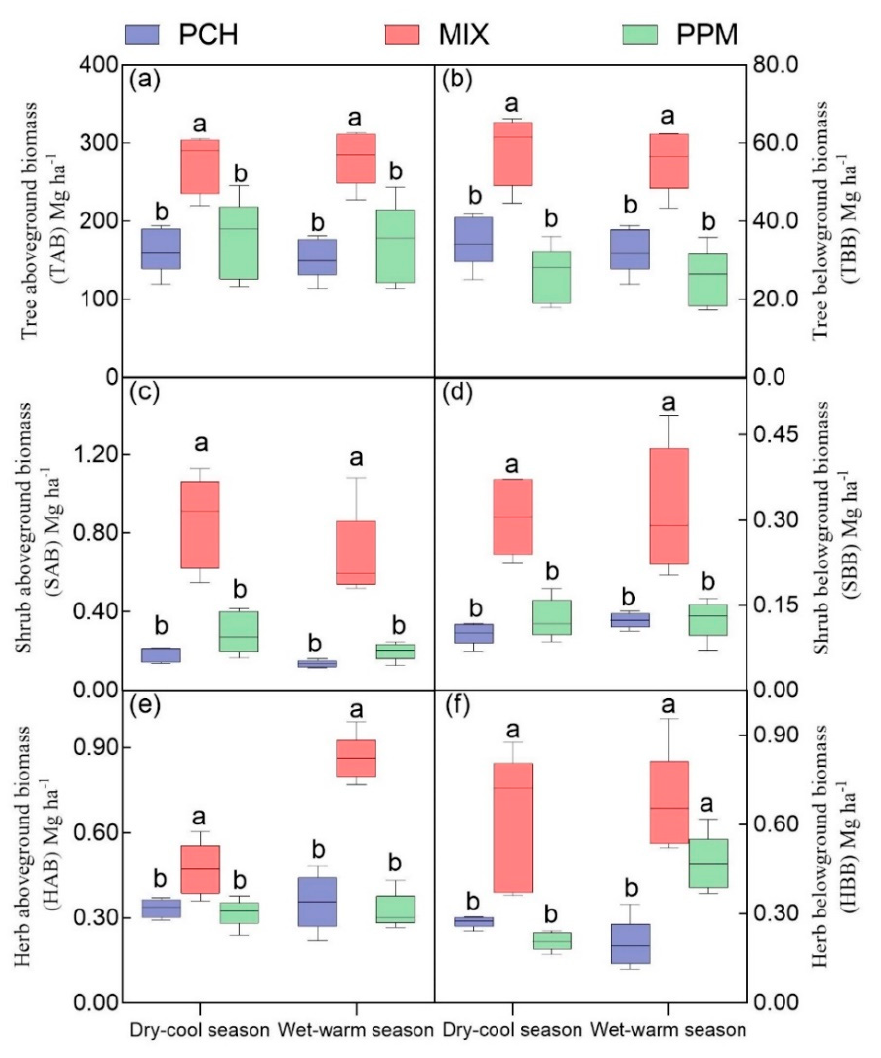
Figure 1. Biomass of trees ( a , b ), shrubs ( c , d ) and herbs ( e , f ) in three plantations in different seasons. Different letters above the bars denote significant differences at p < 0.05 level by LSD (least significant difference) multiple comparisons among stand types ( n = 5).